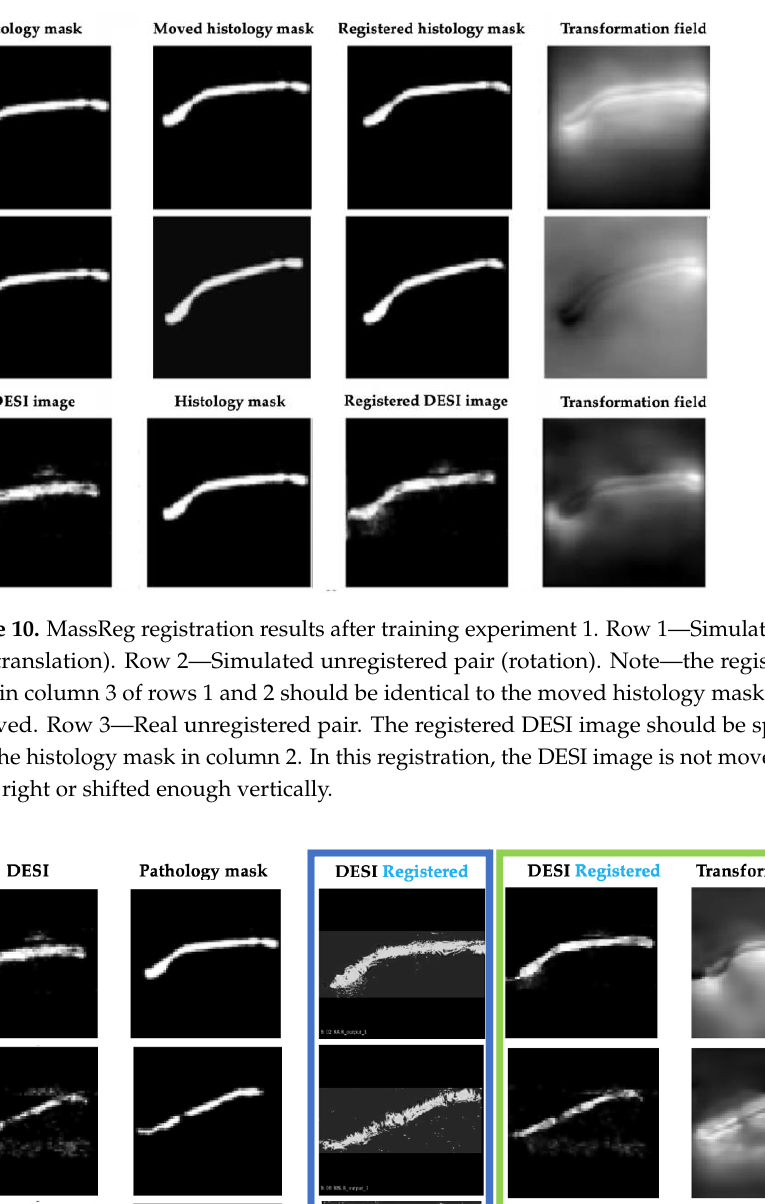
Figure 11. MassReg registration results after experiment 2 of training on real un-registered image pair. Left to right: DESI-MS images, corresponding pathology masks, registered DESI images with Elastix, registered DESI images with MassReg, transformation field from MassReg output.